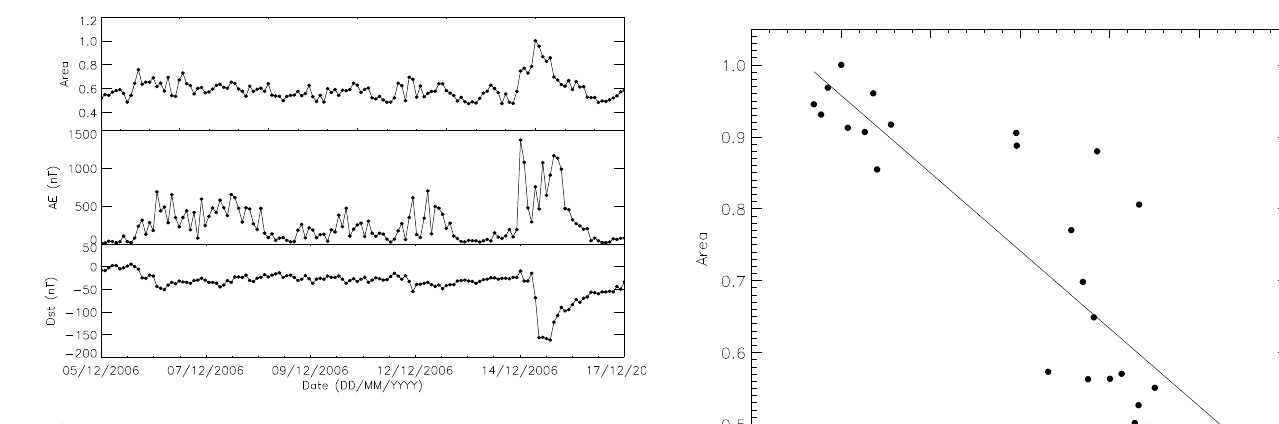
Figure 11. The variations of the area and the AE and Dst indices during 5–17 December 2006. The black dots represent the selected time to be calculated and the y axis of top panel has been normal- ized.